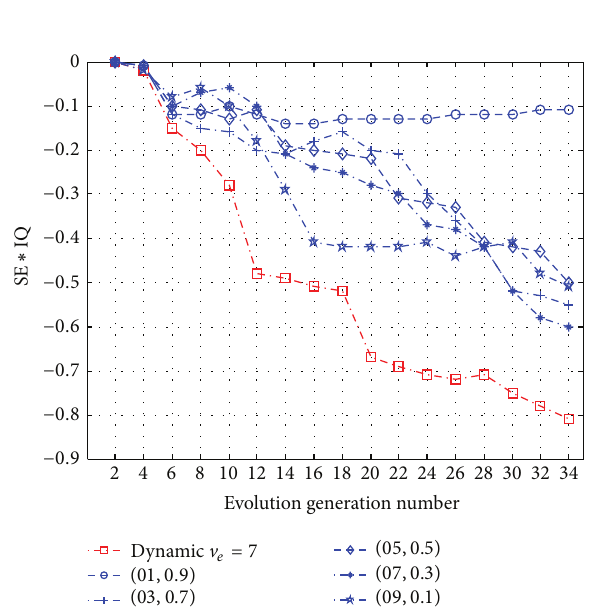
Figure 6: The relationship between creative style with SE (𝑡)∗ IQ (𝑡)